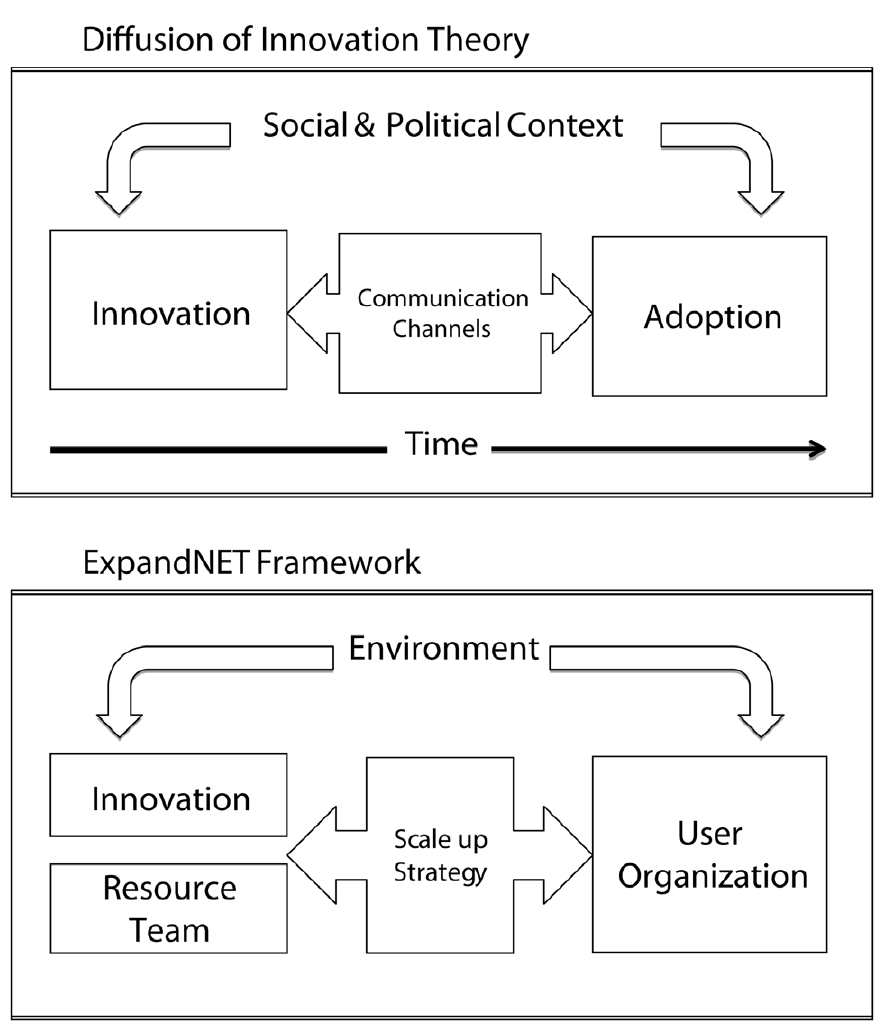
Figure 1. Comparison of Diffusion of Innovation and ExpandNet frameworks. A comparison of the DOI and ExpandNet frameworks is shown. Whereas the DOI describes the process through which innovations are adopted and diffused through the population, the ExpandNet framework specifically addresses the diffusion and scale-up of public health interventions. As highlighted in the figure, the ExpandNet framework reflects the earlier thinking of the DOI and incorporates the elements of context as environment, communication channels as scale-up strategy, and adoption by the population as adoption by the organization implementing the intervention.